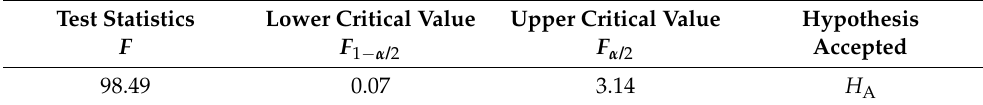
Table 3. Key parameters of the conducted two-tailed F -test of the equality of variances.